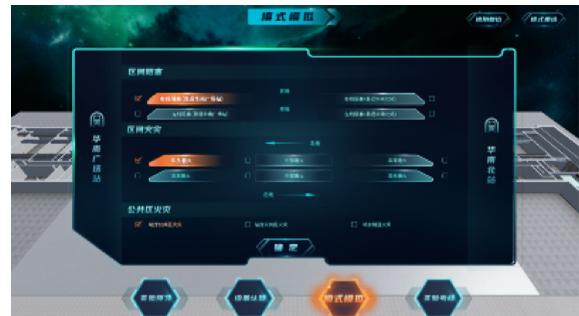
Figure 7. Mode simulation module.